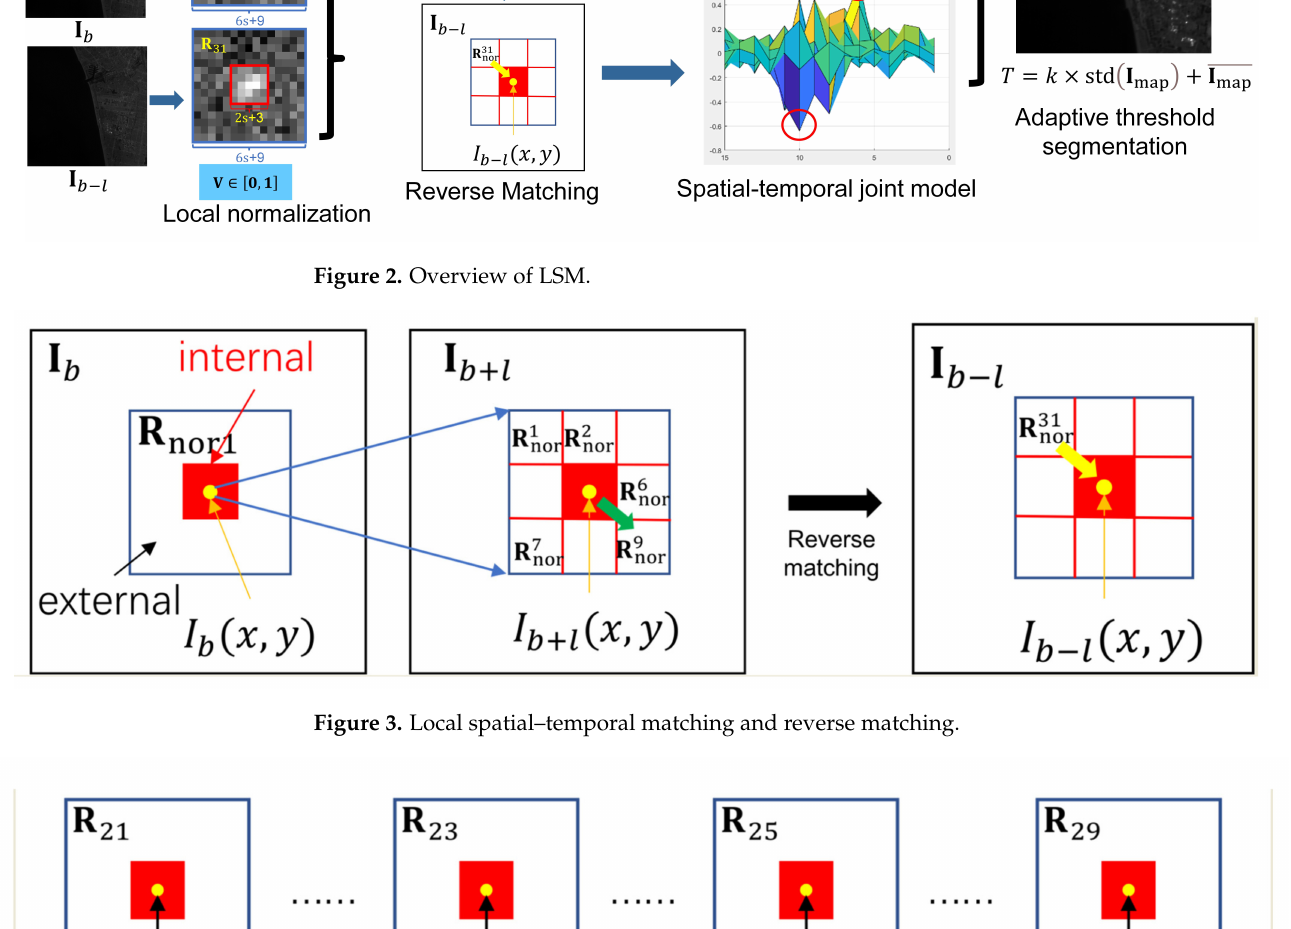
Figure 4. Positions of the local slices in the reference frame I b + l